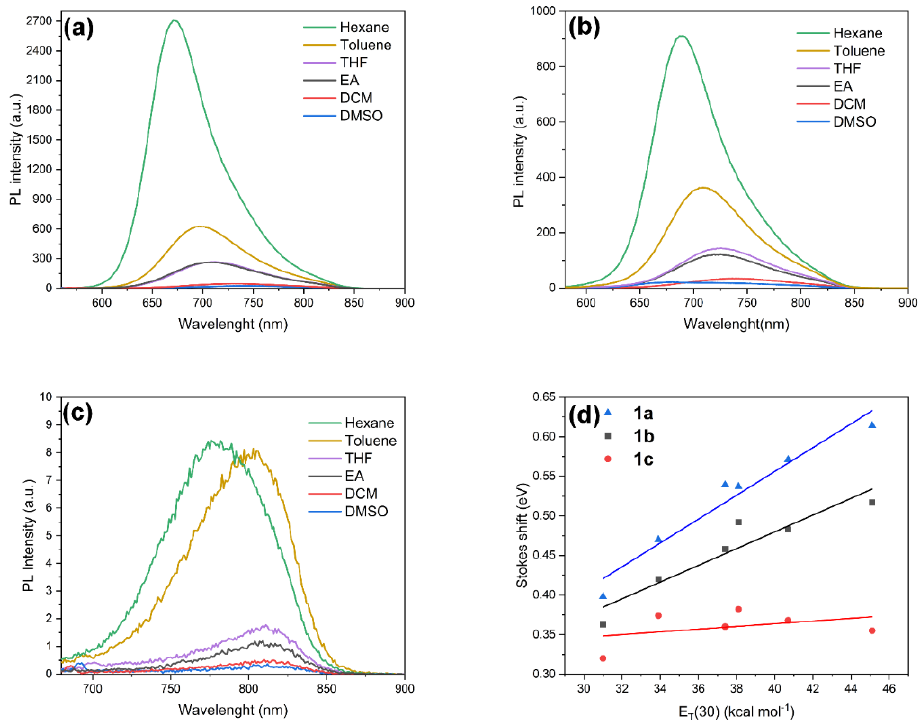
Figure 5. Emission band of 1a – c (0.01 mM): ( a ) 1a ( λ exc = 570 nm); ( b ) 1b ( λ exc = 541 nm); ( c ) 1c ( λ exc = 647 nm); ( d ) Stokes shift against Dimroth–Reichardt’s solvent polarity parameter E T (30): solid lines are fitting lines for each data set.